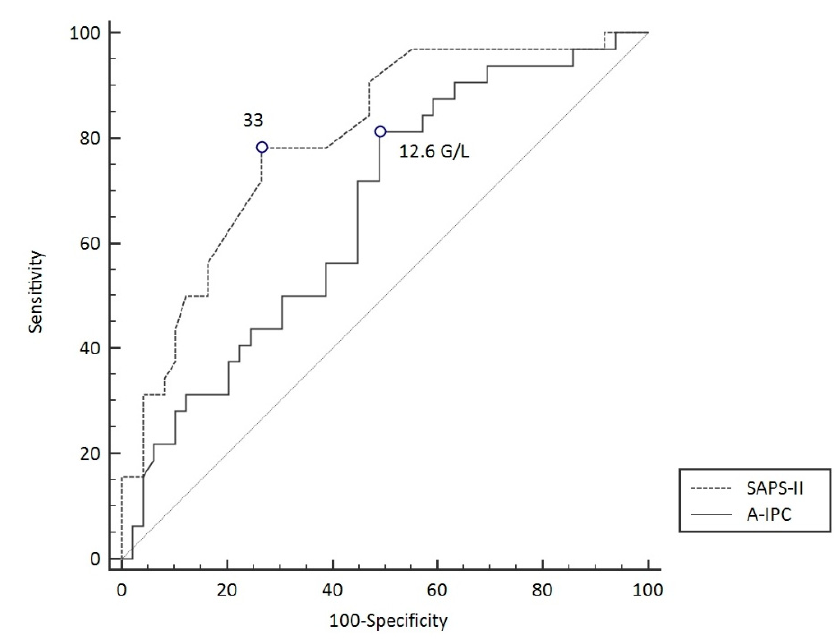
Figure 3. ROC curve models to predict worsening in COVID-19 patients.